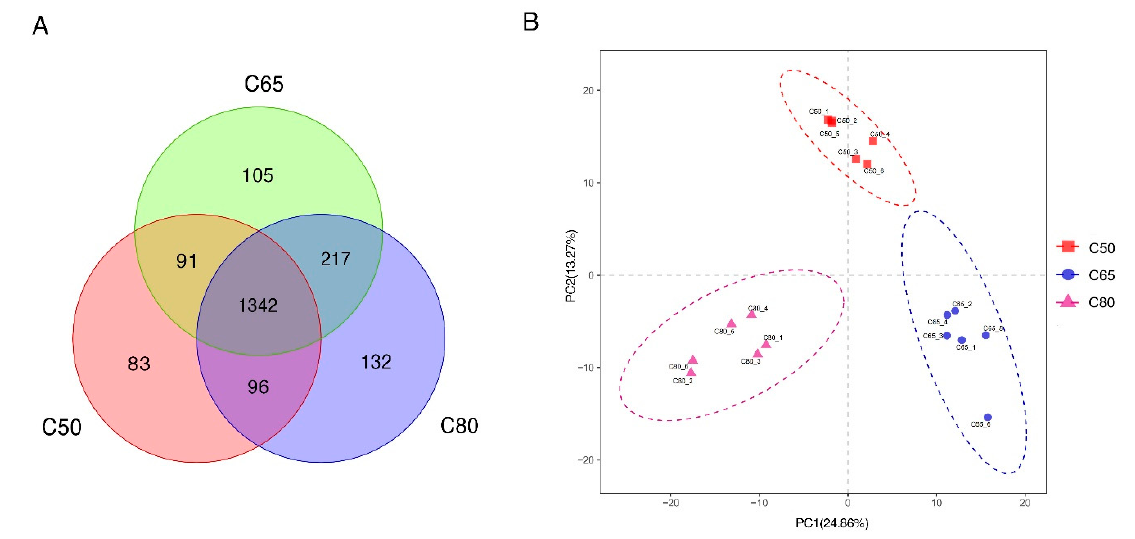
Figure 1. Differences of fecal bacterial community richness and OTUs in yak with concentrate-to- forage ration. Venn diagram ( A ) shows the three different kinds of fine forage than diet and similar OTUs. Principal coordinate analysis (PCoA) ( B ) of the fecal microbiota of yak with three concentrates to forage ratio diets.